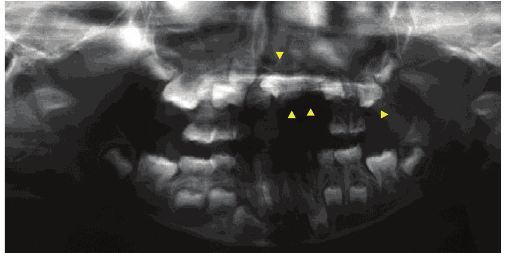
Figure 2: Panoramic radiograph at initial visit (case 1). Sev- eral permanent maxillary teeth are malformed and hypocalcified (arrowheads).